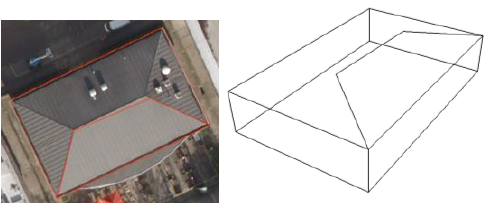
Figure 8. Results of LoD2 reconstruction for a hipped